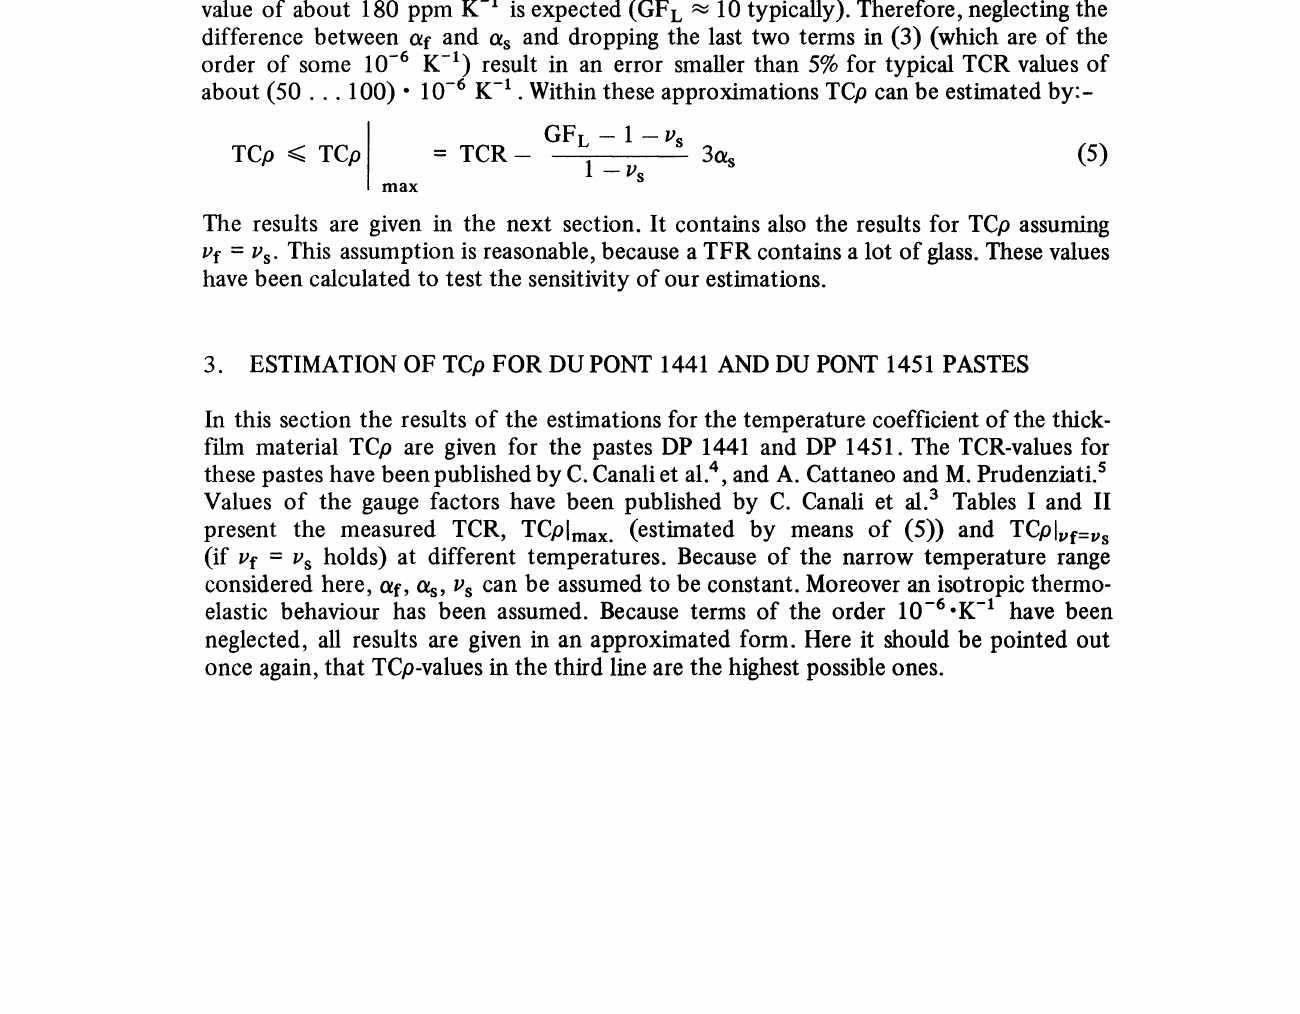
FIGURE Behaviour of the solution of eqn (3) with increasing vf holds. Thus in a rough approximation p-" bp/Oe GFL, and for the second term in (3) a value of about 180 ppm K -1 is expected (GFL 10 typically). Therefore, neglecting the difference between Otf and as and dropping the last two terms in (3) (which are of the order of some 10 -6 K -1) result in an error smaller than 5% for typical TCR values of about (50...